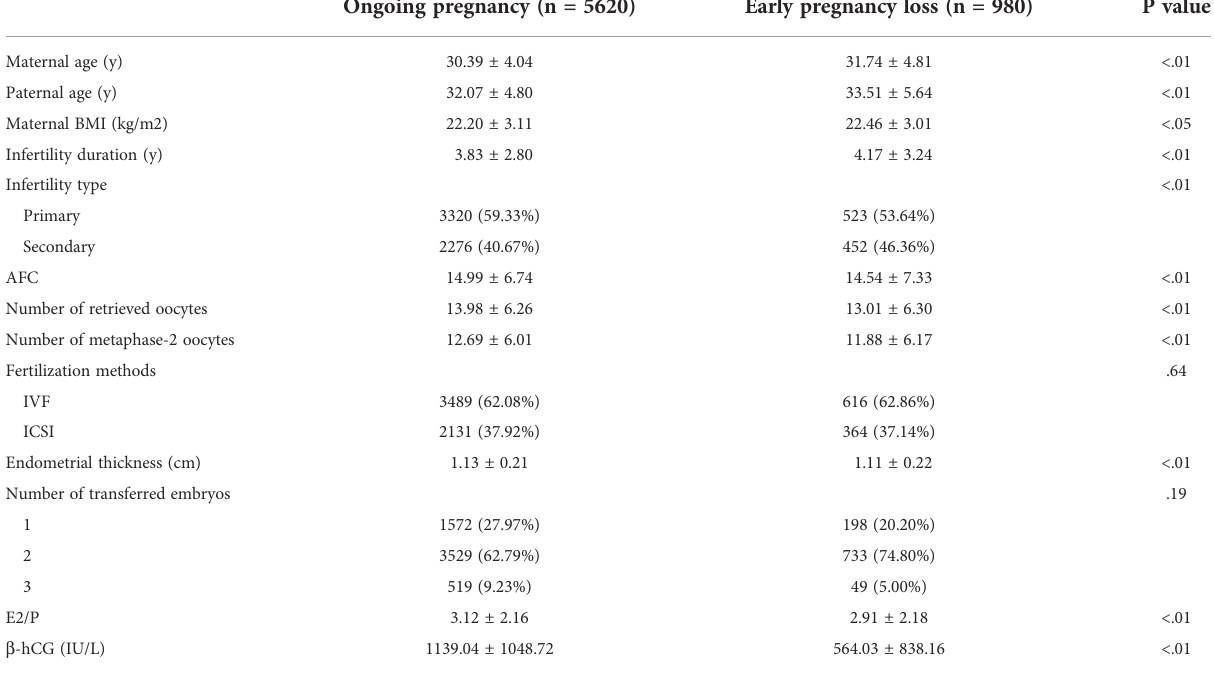
TABLE 1 The characteristics of cycles in the study population(N=6600).